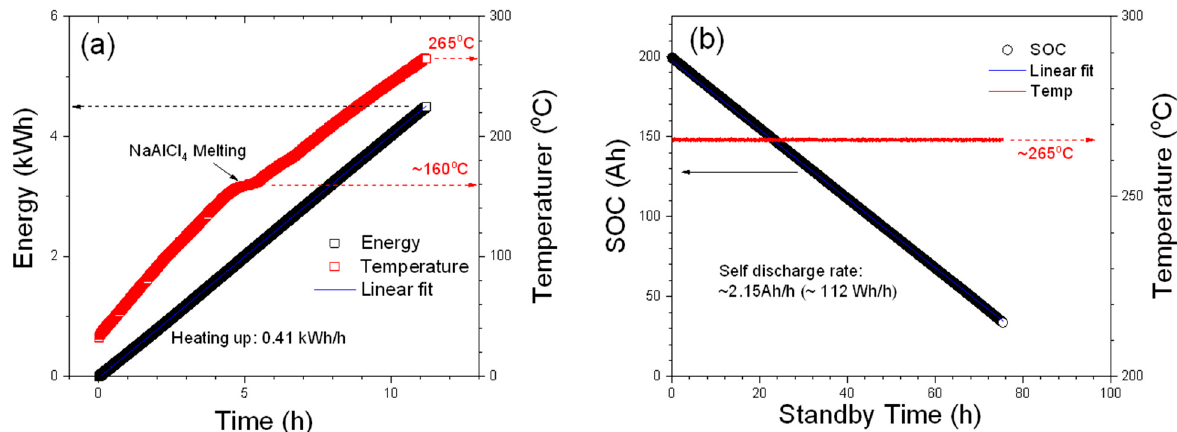
Figure 5. Initial heating-up and standby modes of the module. ( a ) Consumed energy and temperature of the heating-up process; ( b ) SOC and temperature of the module during the standby mode without getting power from external battery cycler.